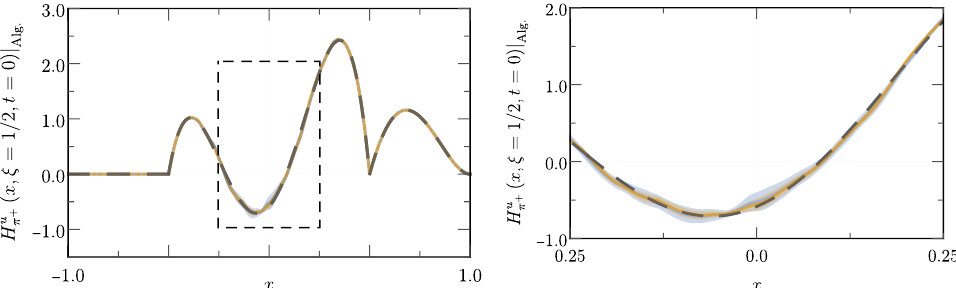
Figure 11. Left : results of the reconstuction of the DD of Equation (79). Black, exact GPD computed from the algebraic DD (79). Blue, reconstructed GPDs with a sample of H i roughly four times the number of cells. Orange, same but with a sample of 12 times the number of cells. Right : zoom on the central region to highlight the uncertainty